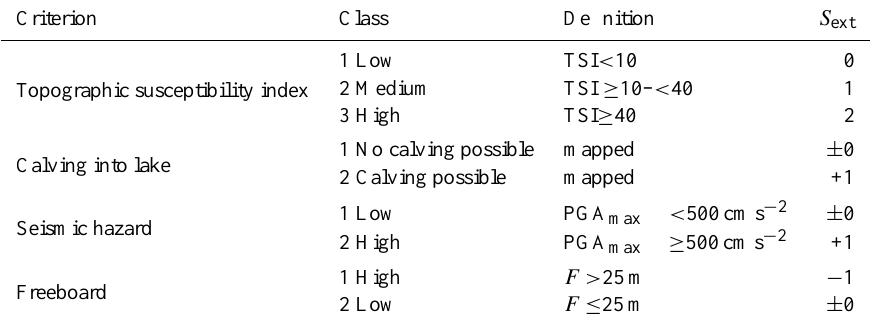
Table 2. Rating scheme for susceptibility to outburst triggered by external forces S ext . Initial values of S ext are determined from the topographic susceptibility index. These values are then increased or decreased according to the possibility of calving, seismic hazard and